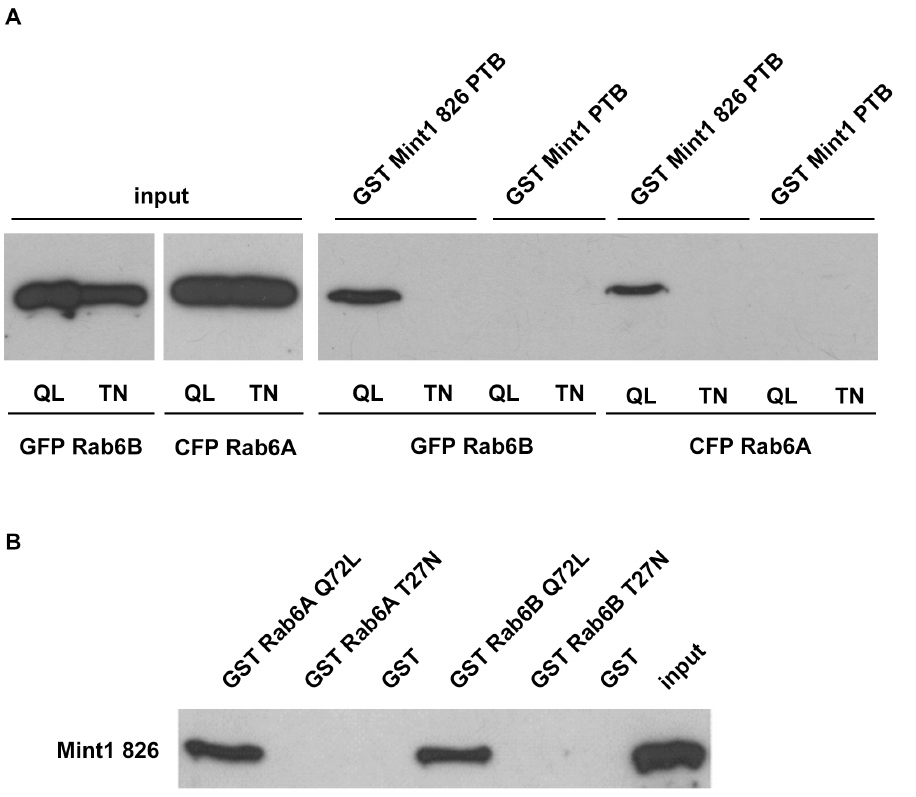
Figure 2. Verification of the interaction between Mint1 826 and Rab6 isoforms using GST pulldown experiments. 10 m l of Glutathione Sepharose TM 4B beads were coated with GST or the denoted GST fusion protein and then incubated with the designated prey protein. Samples were analyzed by Western blotting using an anti-GFP (a) or anti-Mint1 (b) antibody. QL: constitutively active variant (Q72L), TN: inactive variant (T27N). A) 5 m g of the GST Mint 1 fusion proteins were incubated with lysates of stably transfected HeLa T-REx TM cells overexpressing Rab6 GFP or CFP fusion proteins (20 6 input) for 1.5 h at 4 u C. B) 1 m g of the GST Rab6 fusion protein was incubated with 300 ng of Mint 826 for 1 h at 4 u C. Mint1 826 was isolated from thrombin cleaved bacterially expressed GST Mint1 826. input: 50 ng Mint1